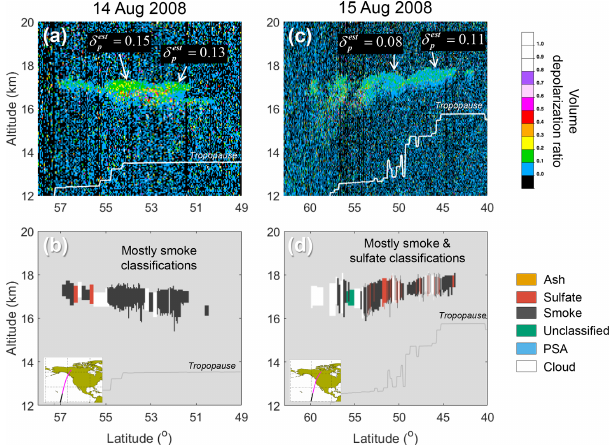
Figure 19. Possible ash–sulfate mixtures from the 2008 Kasatochi eruption; 532nm volume depolarization ratio and V4.5 aerosol type classifications from the level 2 aerosol profile product on (a, b) 14 August 2008 at ∼ 11:30UTC and (c, d) 15 August 2008 at ∼ 10:30UTC. Estimated particulate depolarization ratios for select layers are indicated by call-outs in upper panels. Inset maps show CALIOP ground